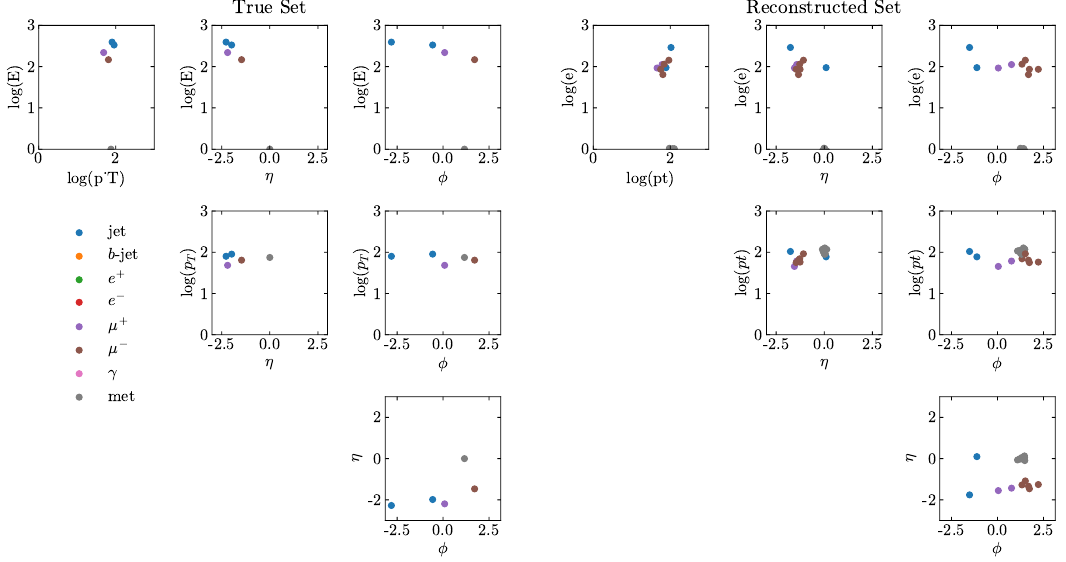
Figure 3: Illustrative example of the input and output structure of the network. The left panels show the original event in different two dimensional slices. The color of each point denotes the type of object. This event is from Channel 2b and contains two jets, a muon pair, and missing transverse momentum. The right panels contain the encoded-decoded set, and there are more objects than in the original